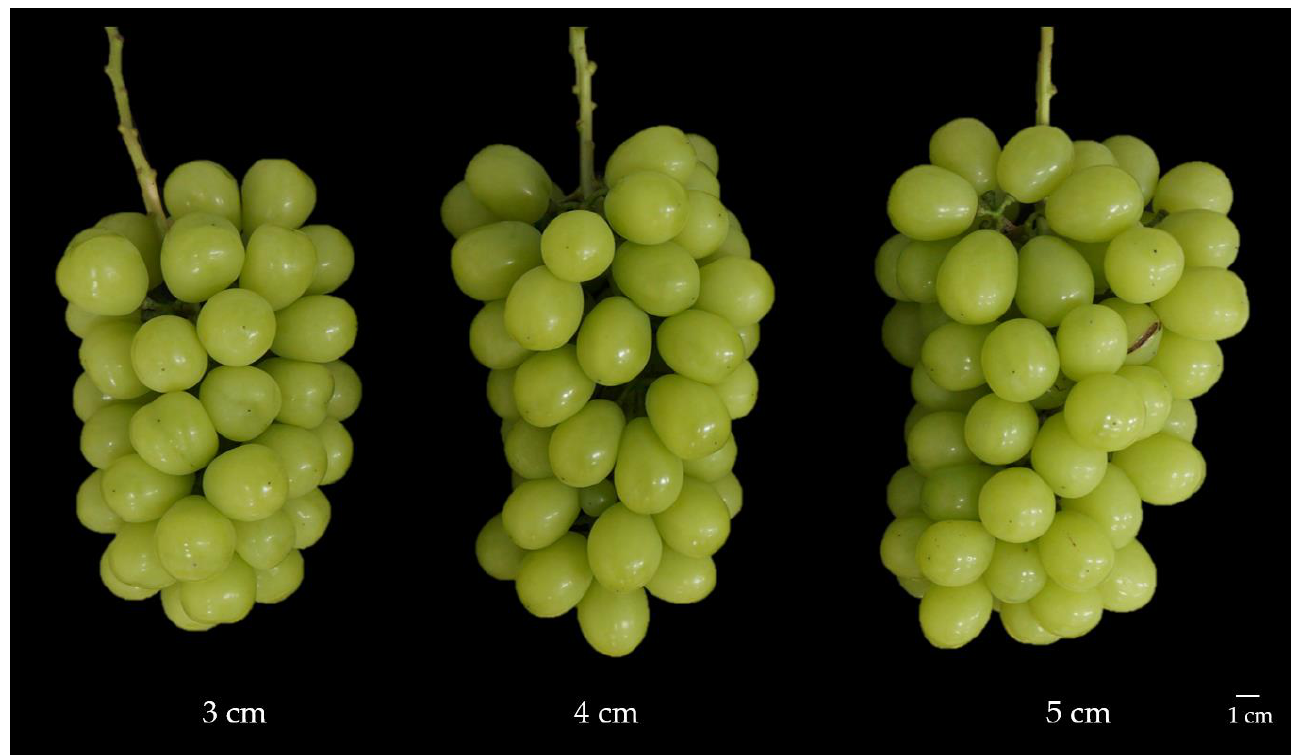
Figure 4. The shape of ‘Shine Muscat’ grapes at harvest according to different degrees of thinning to 3 cm, 4 cm, and 5 cm. Thinning was performed seven days before the full bloom. Table 5. Effects of different lengths of floral cluster thinning by hand on the berry development of the ‘Shine Muscat’ grape at harvest time .